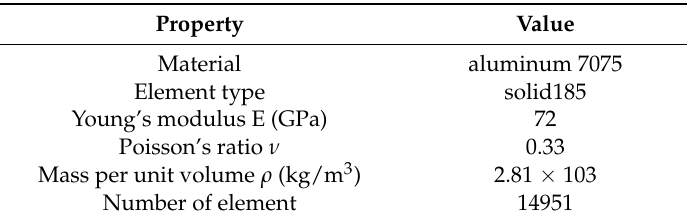
Table 2. Properties of FE model in ANSYS.